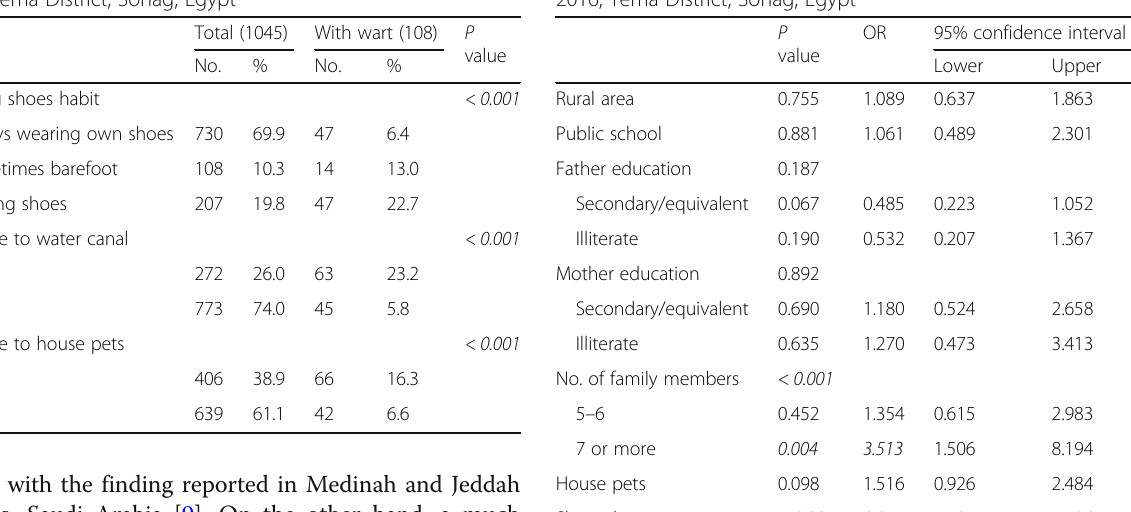
Table 3 Relation between wart infection and some lifestyle